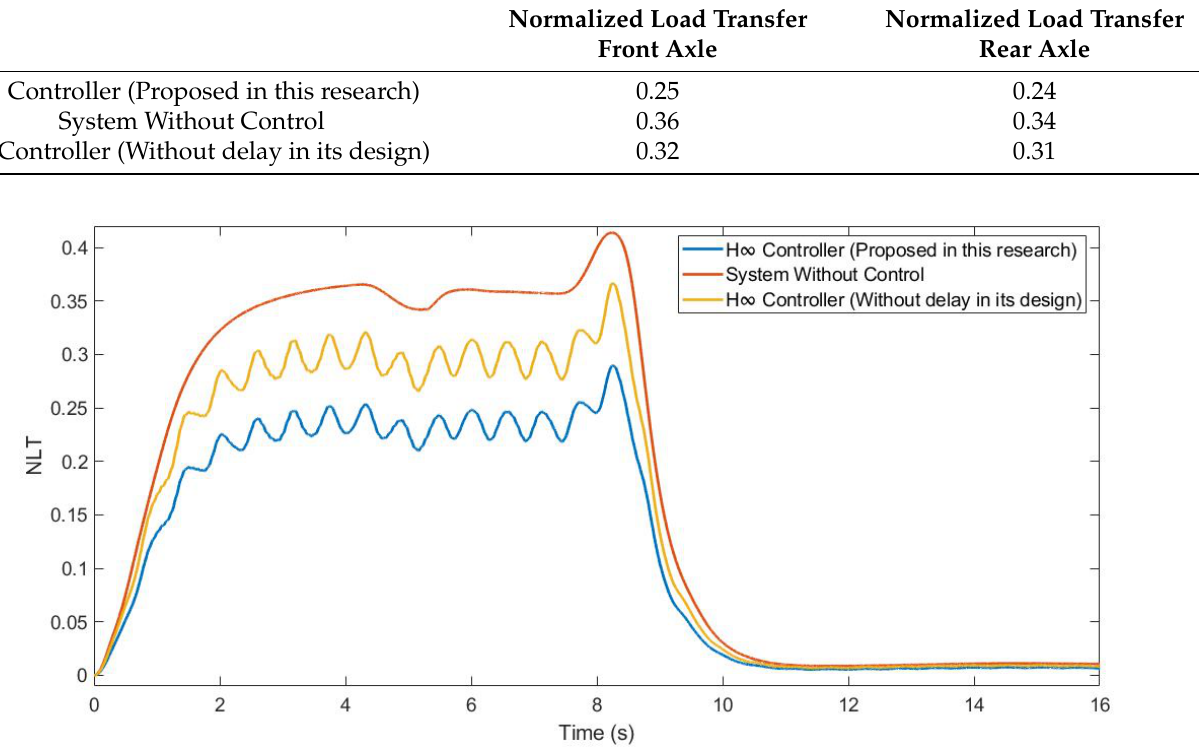
Figure 12. NLT of front axle for test 1: Roundabout at 30